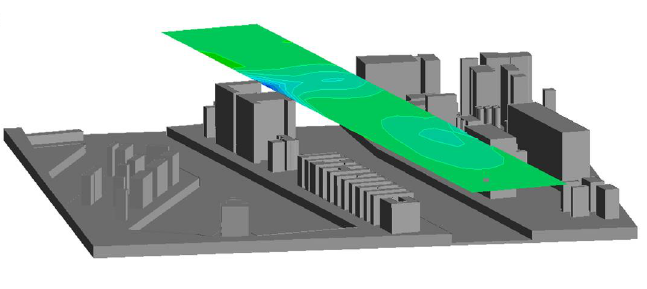
Figure 17. The simulation results presented for the horizontal plane at the height of 15 m, whereas Table 4 shows the values for the simulation at a height of 15 m. Table 4. Comparison of CFD simulation.